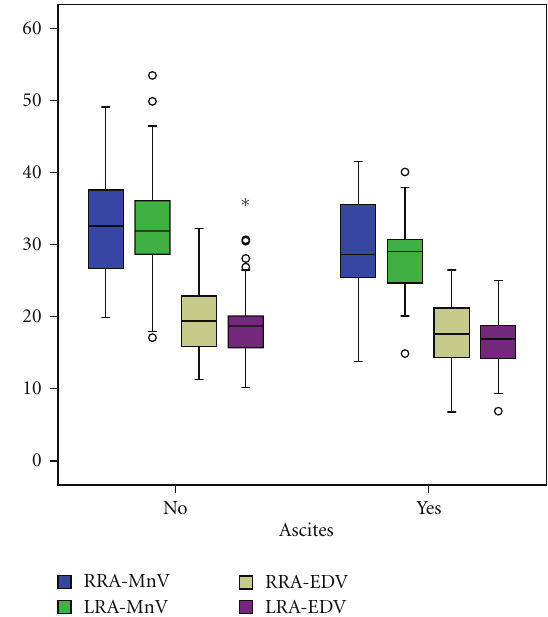
Figure 4: The values of RRA/LRA-PI in patients with compensated and decompensated liver cirrhosis.